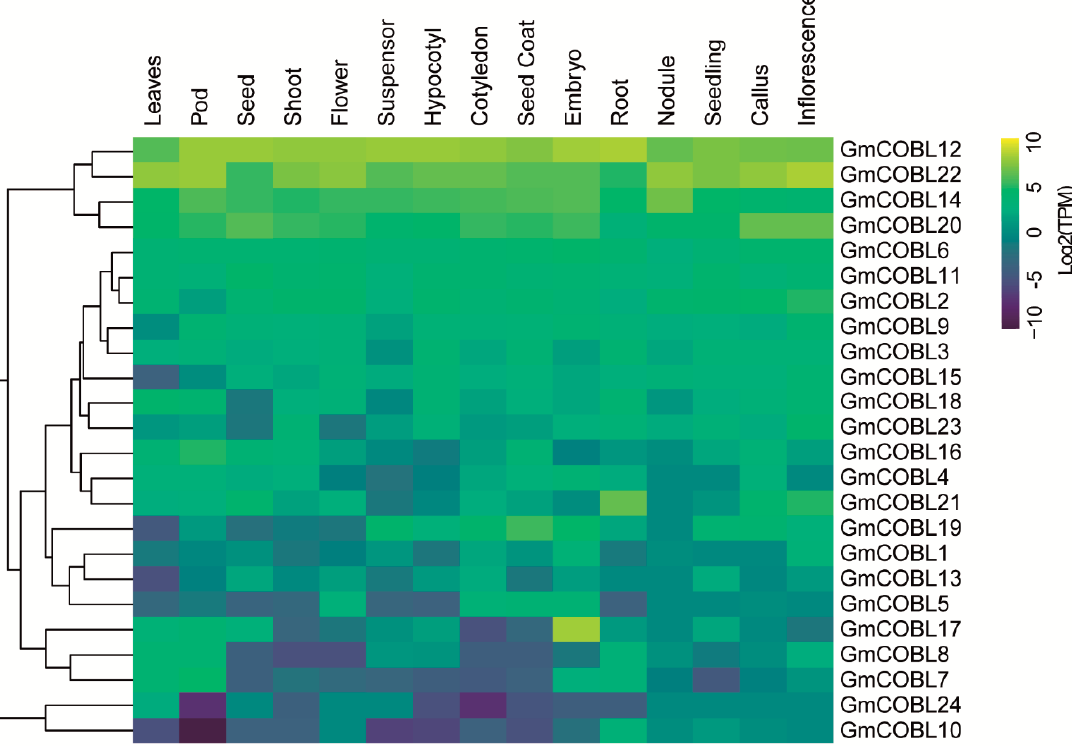
Figure 3. Log2 expression (TPM) of GmCOBL in different tissues and organs. Yellow and blue colors indicate high and low expression, respectively.